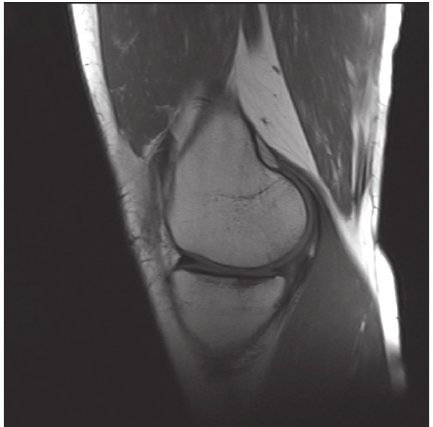
Figure 1: Coronal MR image demonstrates decreased volume of the medial meniscus and a meniscal fragment within the intercondylar notch.